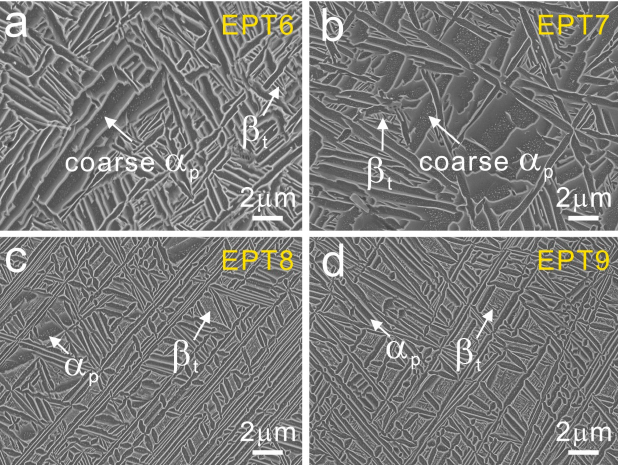
Figure 4. OM images of the wide bands and narrow bands in TC11 samples after being treated with different EPT voltages: ( a ) EPT6; ( b ) EPT7; ( c ) EPT8; ( d ) EPT9.